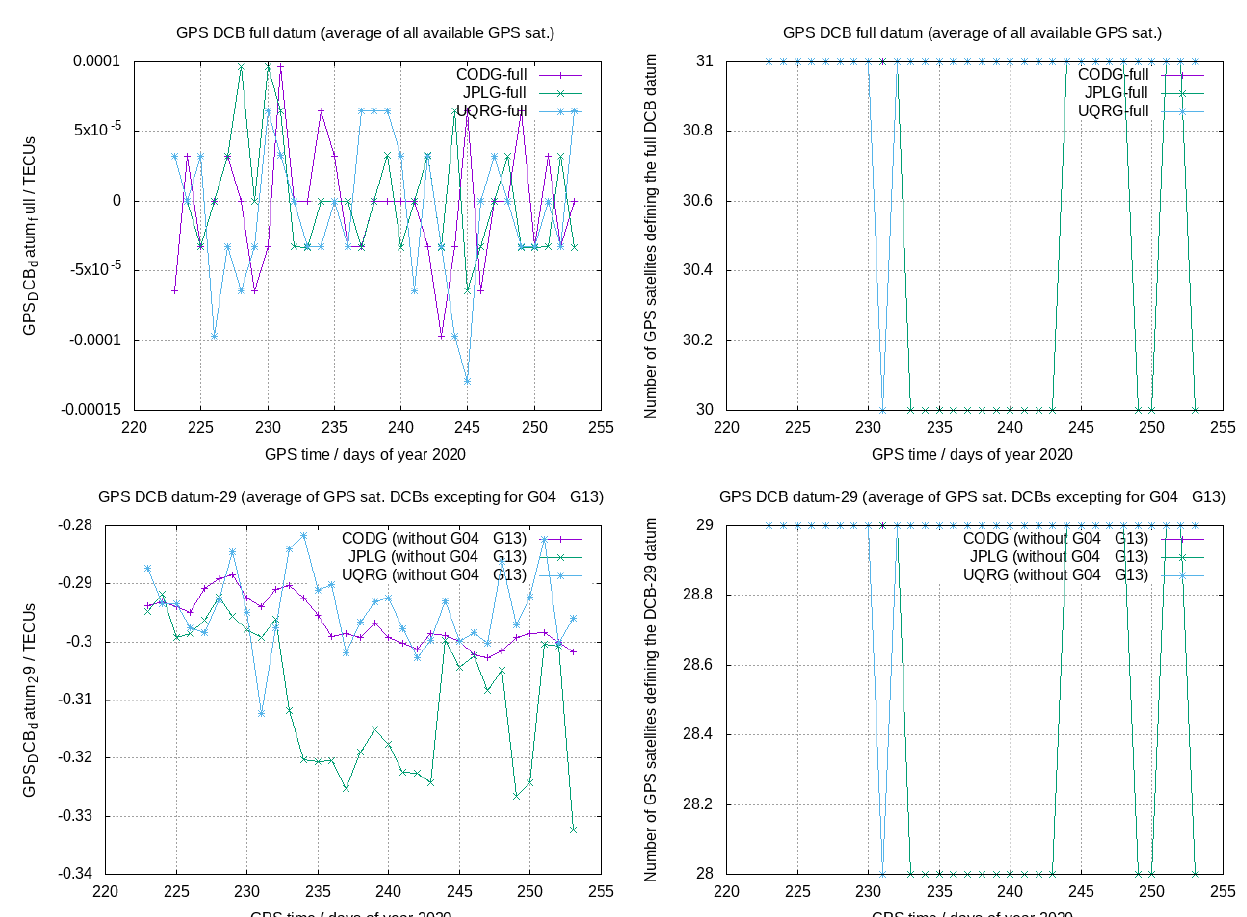
Figure 4. Average of all the available GPS transmitter C2W-C1W DCBs (i.e., GPS data) in the CODE, JPL and UPC-IonSAT GIMs ( top − left ); corresponding number of GPS transmitters ( top − right ). Similarly, for a slightly different datum of 29 transmitters (DCB average excluding GPS04 and GPS13), the GPS DCB data ( bottom − left ) and the corresponding number of GPS transmitters among the 29 ones ( bottom − right